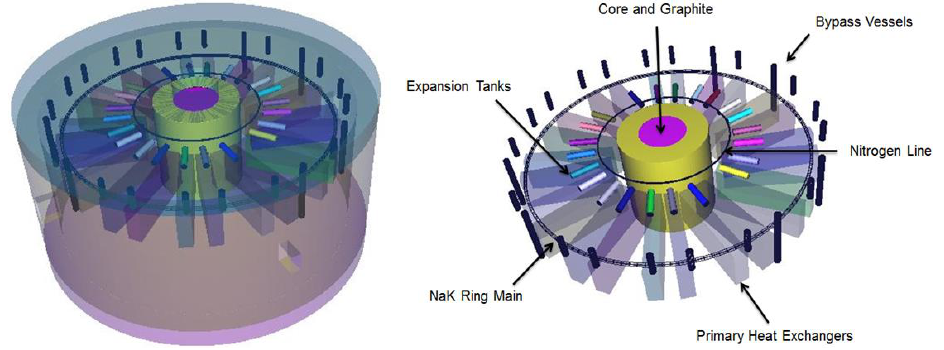
Figure 1. DFR vault geometry model, as displayed in